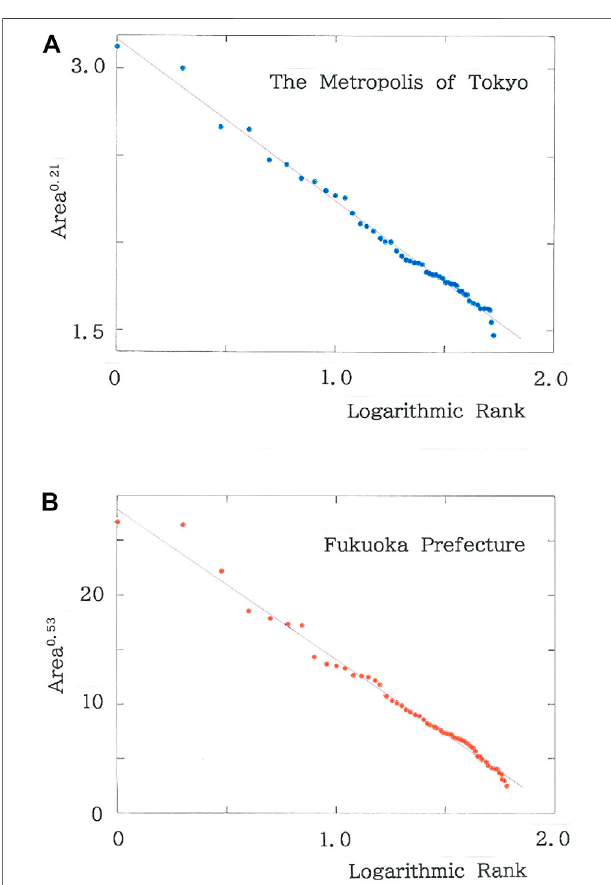
FIGURE 6 | (A) Rank dependence of the areas (km 2 ) of municipalities in the MetropolisofTokyo.Thepurple declininglineindicatestheoptimized fi t(| r | (cid:1) 0.9961with d (cid:1) 1.861 for q (cid:1) 0.21and n (cid:1) 53). (B) Rank dependence ofthe areas (km 2 ) of municipalities in Fukuoka Prefecture. The purple declining line indicates the optimized fi t (| r | (cid:1) 0.9942 with d (cid:1) 1.493 for q (cid:1) 0.53 and n (cid:1) 60).